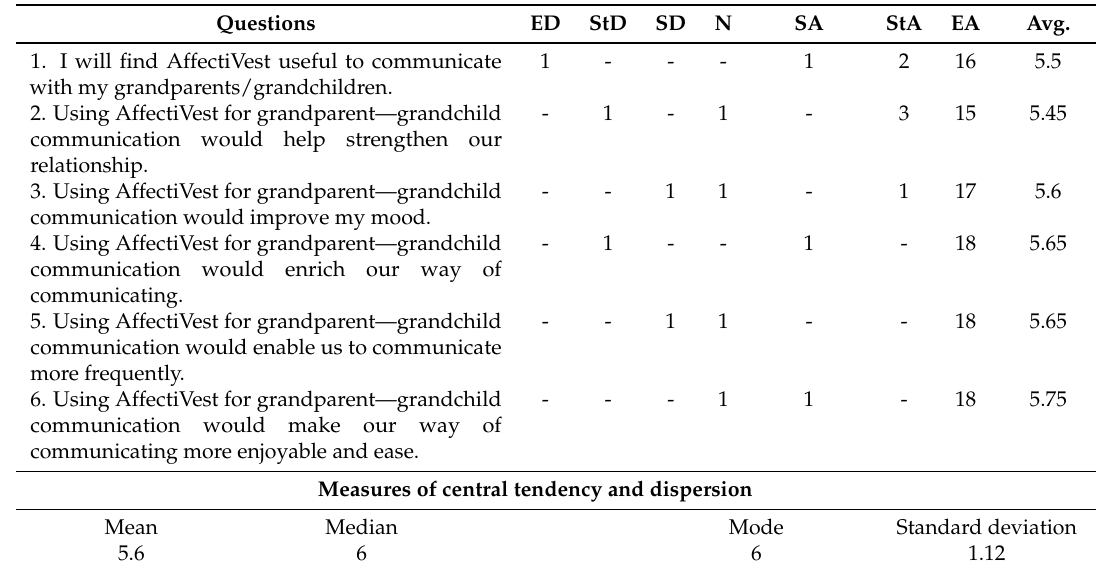
Table 2. Participants’ perceived